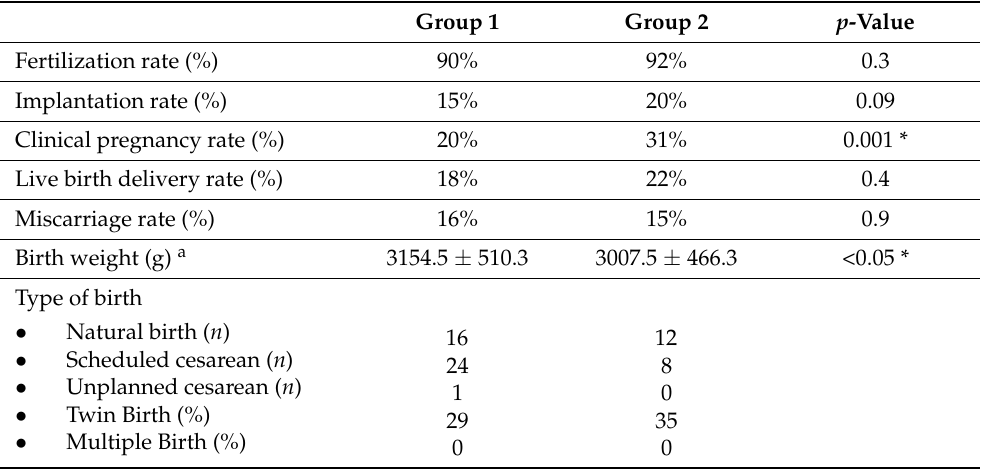
Table 4. ICSI outcomes of the couples of the Group 1 ( n = 223) and 2 ( n = 90).